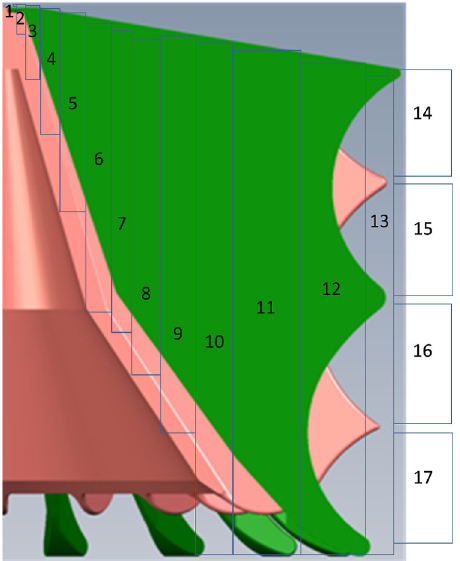
FIG. 21. The block structure for diagnosing electron losses in the Quicksilver simulations of the CSMITL. Blocks 14 – 17 include the vacuum insulator, which is not shown.